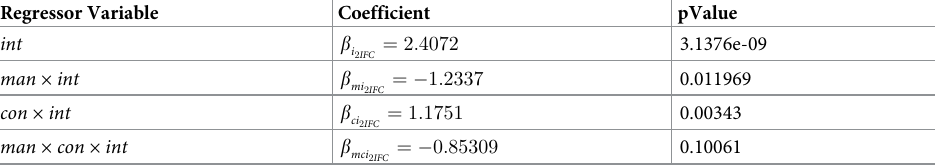
Table 2. Fixed-effects coefficients and associated p-values for the 2IFC-task psychometric